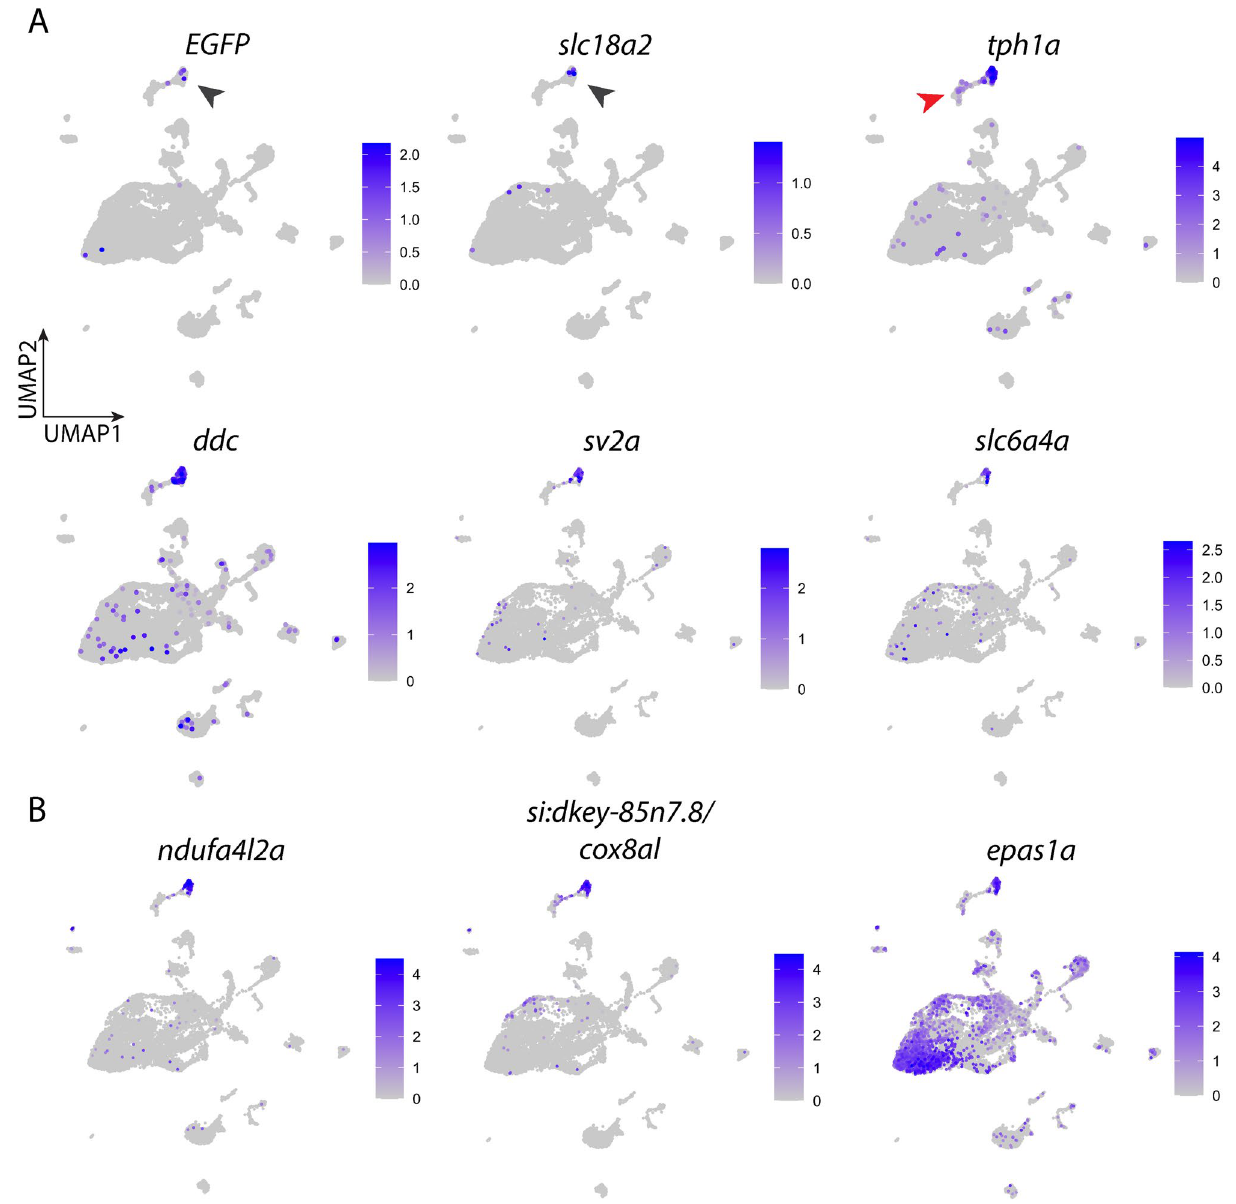
Figure 2. Expression of signature genes found in neuroepithelial cells (NECs). ( A ) UMAP plots showing the log-normalized counts of selective genes involved in identification of NECs. Colour intensity is proportional to the expression level of a given gene. Scales indicate relative gene expression. Black arrowheads indicate high expression in the NEC cluster; red arrowhead indicates expression in the neuron cluster. ( B ) UMAP plots showing the normalized counts of representative genes that may be involved in O 2 sensing in NECs. See text and Table 1 for gene